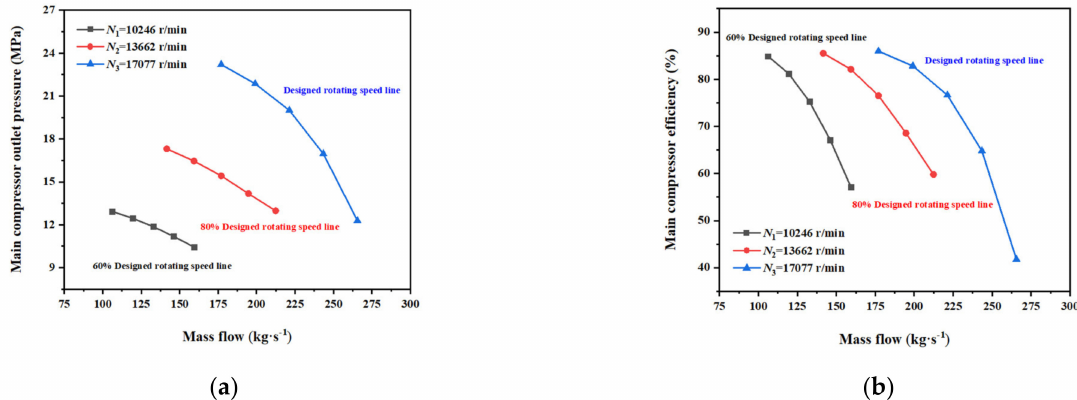
Figure 3. The performance prediction curves of the main compressor. ( a ) Outlet pressure prediction of MC. ( b ) Efficiency prediction of MC.